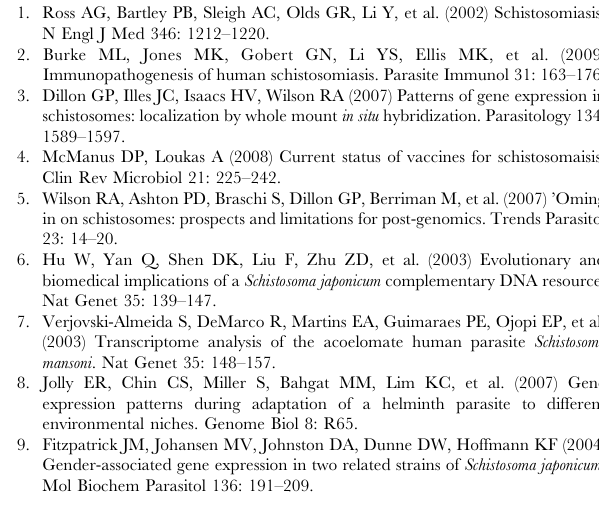
Table S2 Gene Ontology categories from 2 fold or higher differentially expressed gene detected in the three microdissected tissues. Table S3 Primer Sets for real time PCR validation of a subset of genes that were upregulated in the three microdissected tissues examined. Table S4 Complete list of differentially expressed genes, shown on separate sheets of an Microsoft Excel File. ALL DATA